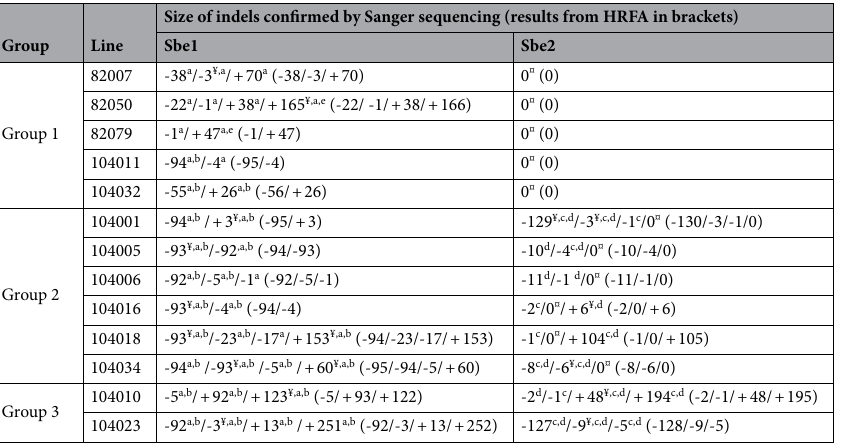
Table 1. Size of indels in respective line analysed with Sanger sequencing and HRFA (in brackets), where “0” indicates the wild type allele fragment size, “–” represents a deletion and “ + ” represents an insertion. Less than four different indels indicates that at least two alleles share the same genetic context. Lack of “0” means no wild type allele remaining in the line. Group 1 represents lines mutated in all four alleles of Sbe1 ; Group 2 represents lines mutated in all four alleles of Sbe1 and two to three alleles in Sbe2 ; Group 3 represents lines mutated in all alleles of both Sbe1 and Sbe2 . ¤ Wild type alleles. ¥ In-frame indels. a Indels at BE1T3 target site, b Indels at BE1T4 target site, c Indels at BE2T3 target site and d Indels at BE2T4 target site. e Insert origination from vector used for in vitro